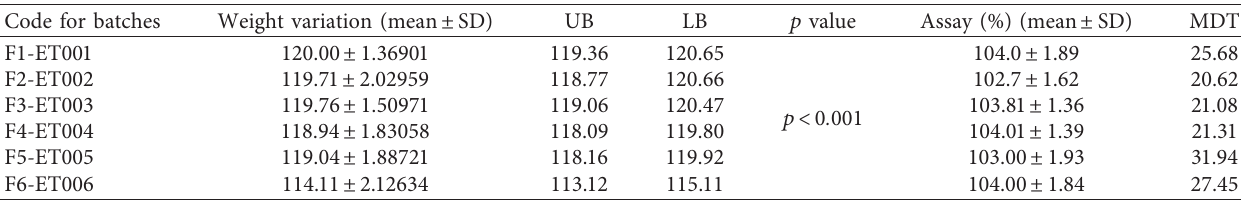
Table 3: Physicochemical characteristics (weight variation and assay test) for ethambutol hydrochloride 100mg tablet batches included in the study ( n � 3).